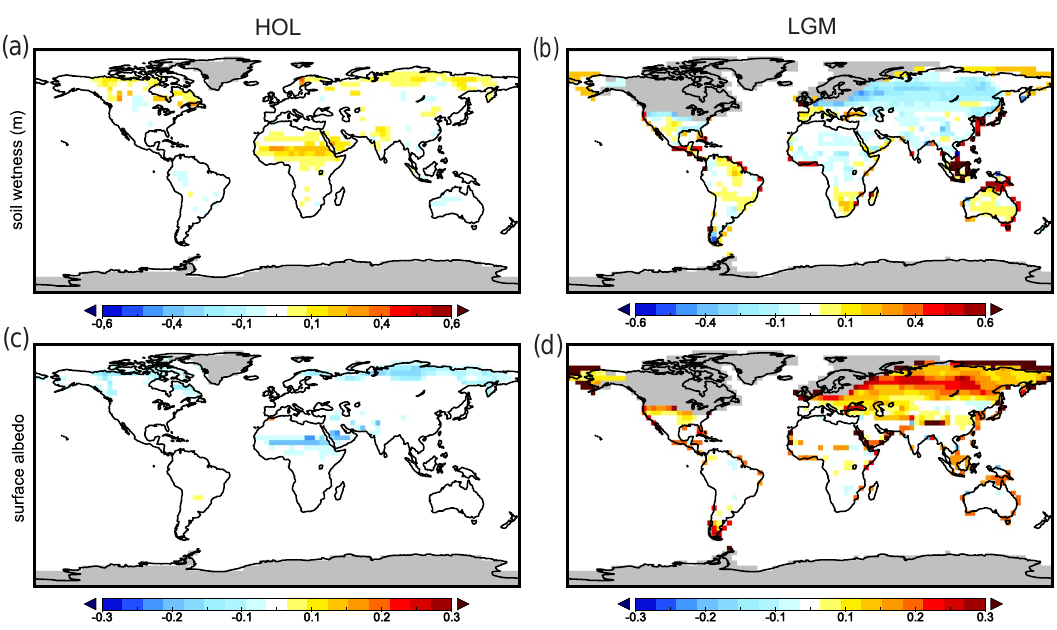
Figure 9. Soil wetness (metres) anomalies of a 100-year annual mean climate state with respect to the preindustrial period for (a) mid- Holocene (HOL_sol – PI_sol) and (b) Last Glacial Maximum (LGM_ sol – PI_sol) and changes in land surface albedo for (c) mid-Holocene (HOL_sol – PI_sol) and (d) Last Glacial Maximum (LGM_sol –